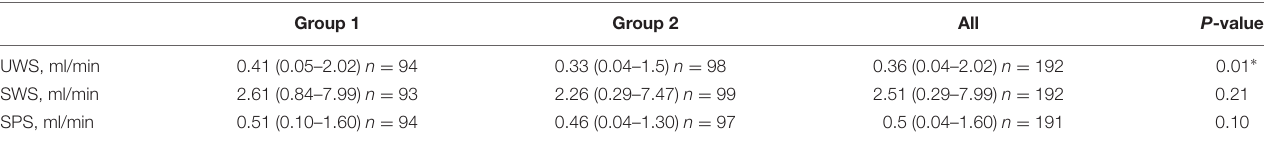
TABLE 3 | Median values (ml/min) of unstimulated whole saliva (UWS), chewing-stimulated whole saliva (SWS), and citric-acid stimulated parotid saliva (SPS) flow rates in group 1 and group 2. Group 1 Group 2 All P